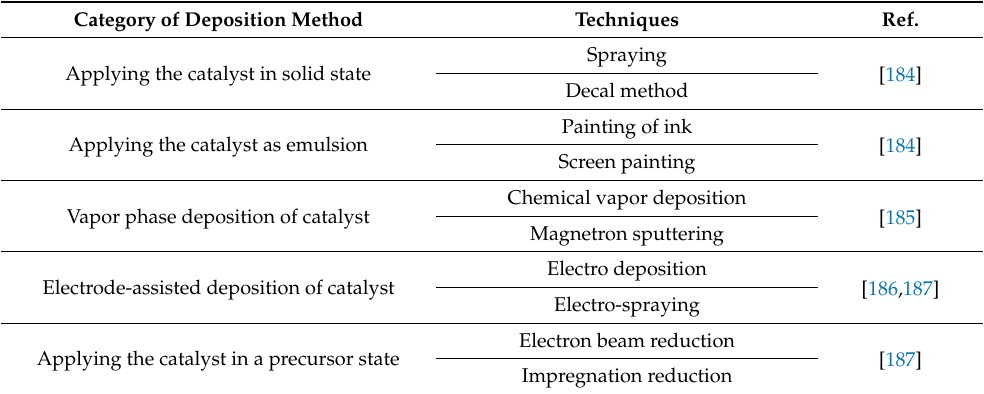
Table 4. Categories of catalyst deposition methods and